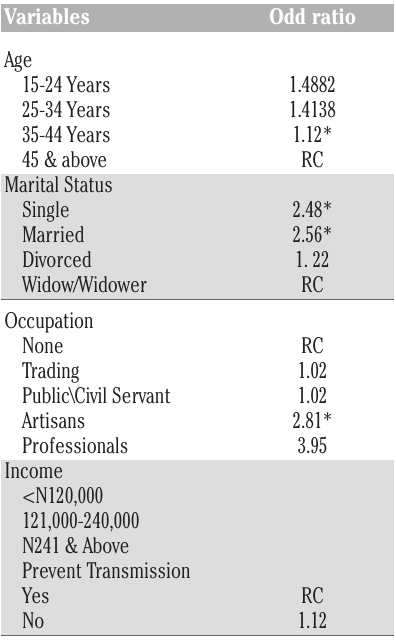
Table 7. Logistic regression of model to identify the socio-economic determinants of